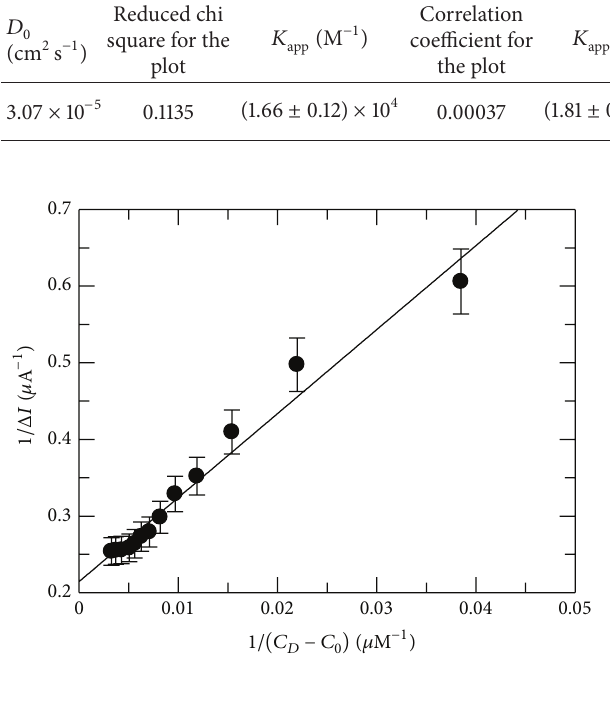
Figure 5: Double reciprocal plot of doxorubicin hydrochloride— CT DNA interaction using cyclic voltammetry; [doxorubicin hydrochloride] = 33 𝜇 M, pH = 7.4, [NaCl] = 0.160 M, and temper- ature = 25 ∘ C.